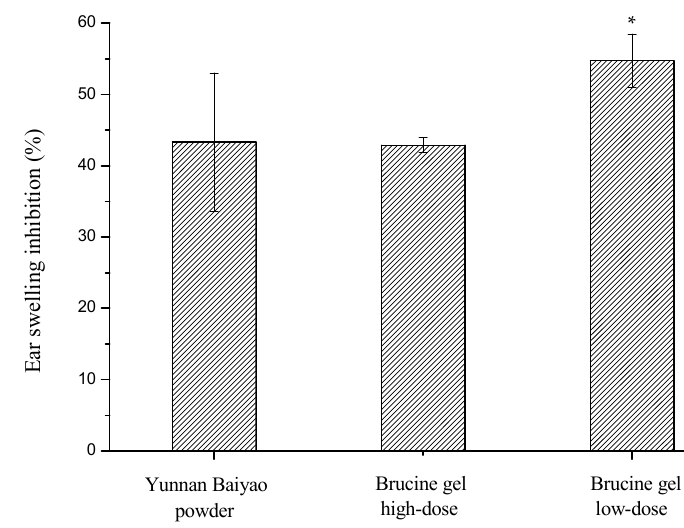
Figure 6. Effect of brucine gel on ear swelling. Symbols represent statistical significance: * ( p < 0.05) compared with control group.